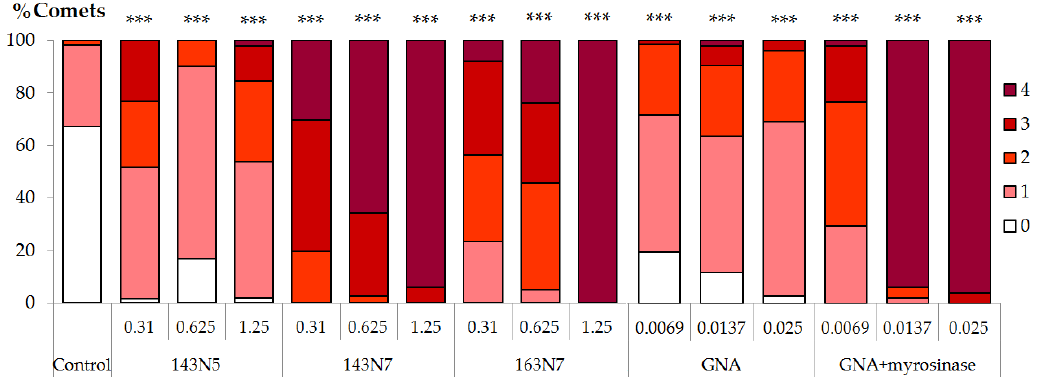
Figure 6. Comet distribution into visual scoring categories in HL-60 cells treated with increasing concentrations of B. rapa , gluconapin and hydrolyzed gluconapin samples (mg/mL). Categories are shown using a red colour scale from white (category 0) to deep red (category 4). *** Significance levels with respect to control ( p ≤ 0.001).